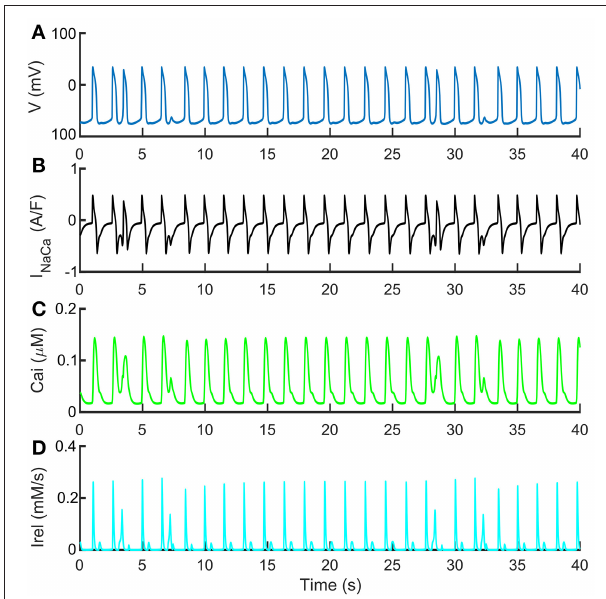
FIGURE 7 | Repolarization abnormalities with standard extracellular Ca 2 + concentrations. Such behavior was obtained with a control extracellular Ca 2 + concentration Ca o = 1.8mM, shifting RyR o,half and RyR c,half by − 0.002 and 0.002mM respectively, doubling RyR o time constant and reducing to half of its nominal value RyR c time constant. These traces show the ability of the Paci2018 to simulate pathological conditions affecting the Ca 2 + from SR. (A) Membrane potential. (B) I NaCa . (C) Cytosolic Ca 2 + concentration. (D) I rel . A similar morphology of the cytosolic Ca 2 + time-course is reported in Kim et al. (2015) in their Figure 4B.